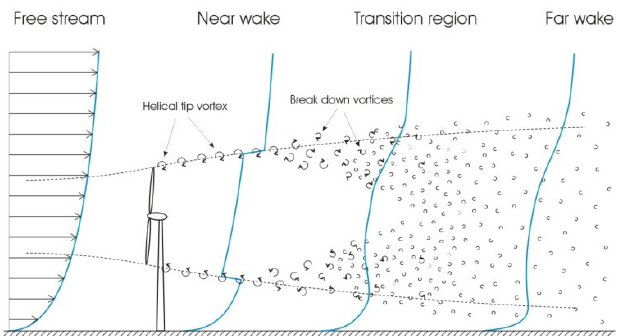
Figure 1. Development of the vertical velocity profile downstream a wind